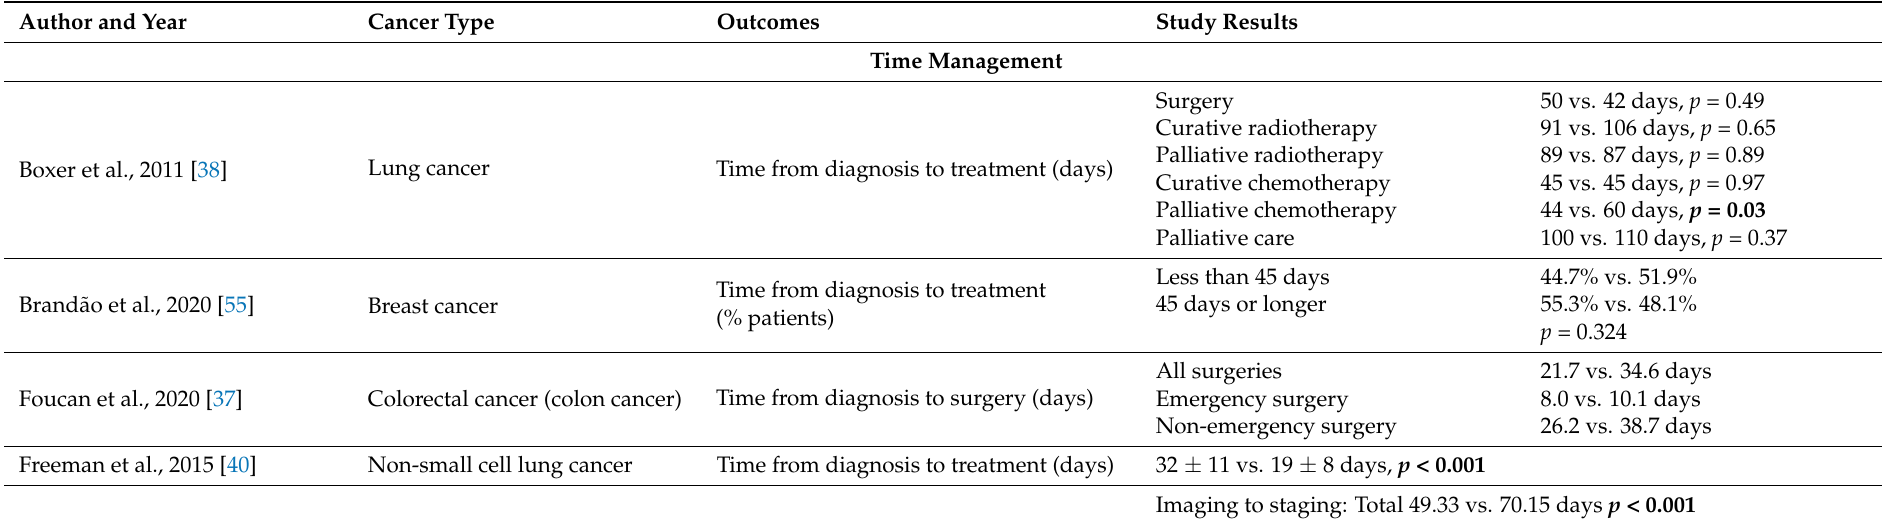
Table 2. Results of process